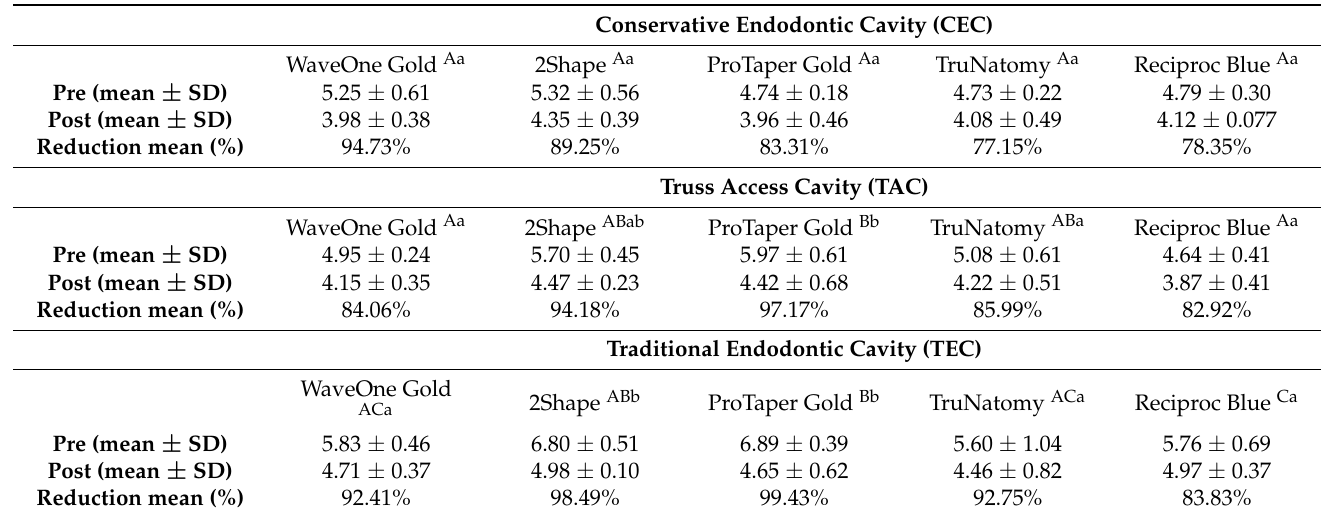
Table 2. Mean values of bacterial counts (in log colony-forming units/mL) in the root canals before and after mechanical instrumentation using different endodontic cavities.